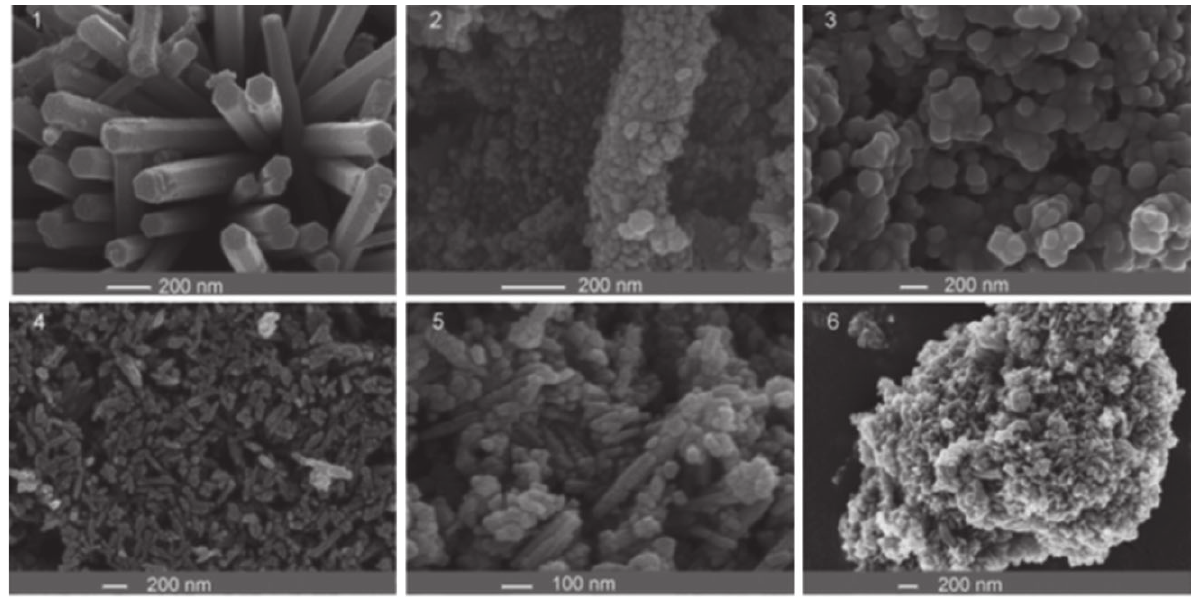
Figure 2 SEM images of ZnO nanostructures generated by ultrasound-assisted decomposition of Zn(OAc) [NTf ], (3) [C 2